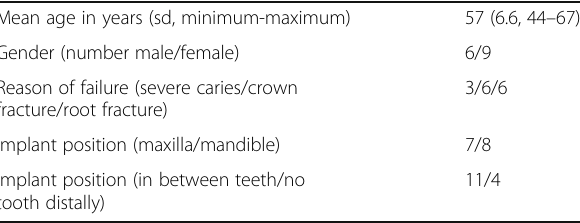
Table 1 Baseline characteristics of the study group